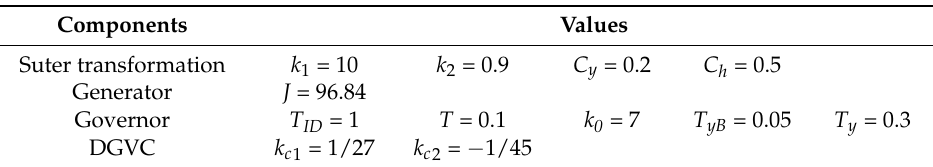
Table 1. Basic parameters of methods.